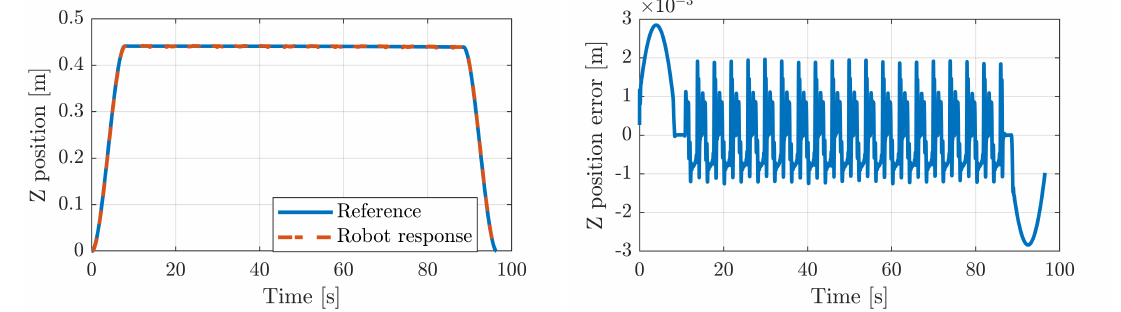
Figure 12. Mobile platform heave of the rehabilitation